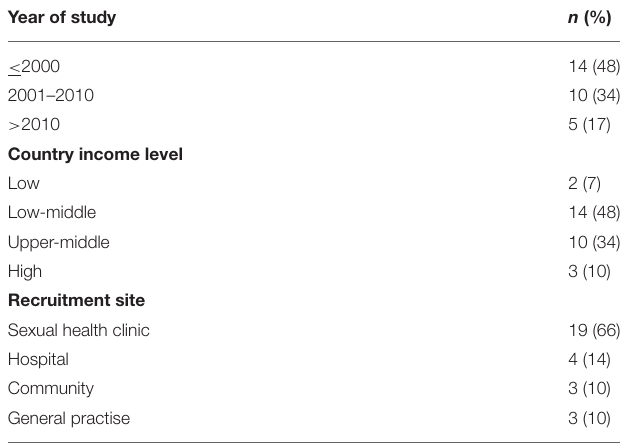
TABLE 1 | Summary of included studies.